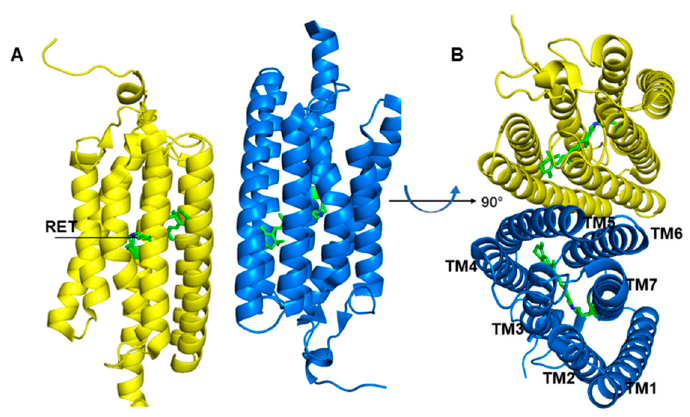
Figure 1. Overall structure presentation of the channelrhodopsin-2 (ChR2) dimer. (PDB ID: 6EID). ( A ) ChR2 side view. ( B ) ChR2 top view. The yellow and blue helixes represent different monomer respectively.